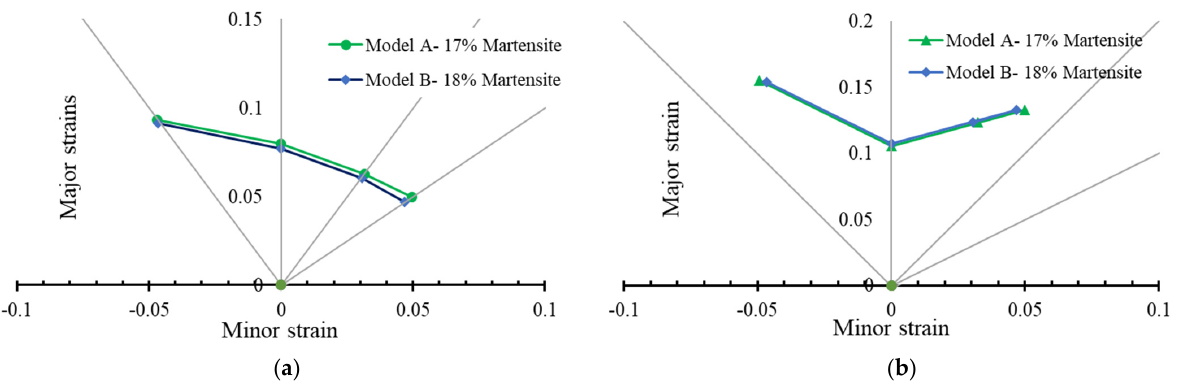
Figure 5. The FLDs in martensite fraction differences in the case of ( a ) M-K approach and ( b ) K-B approach.